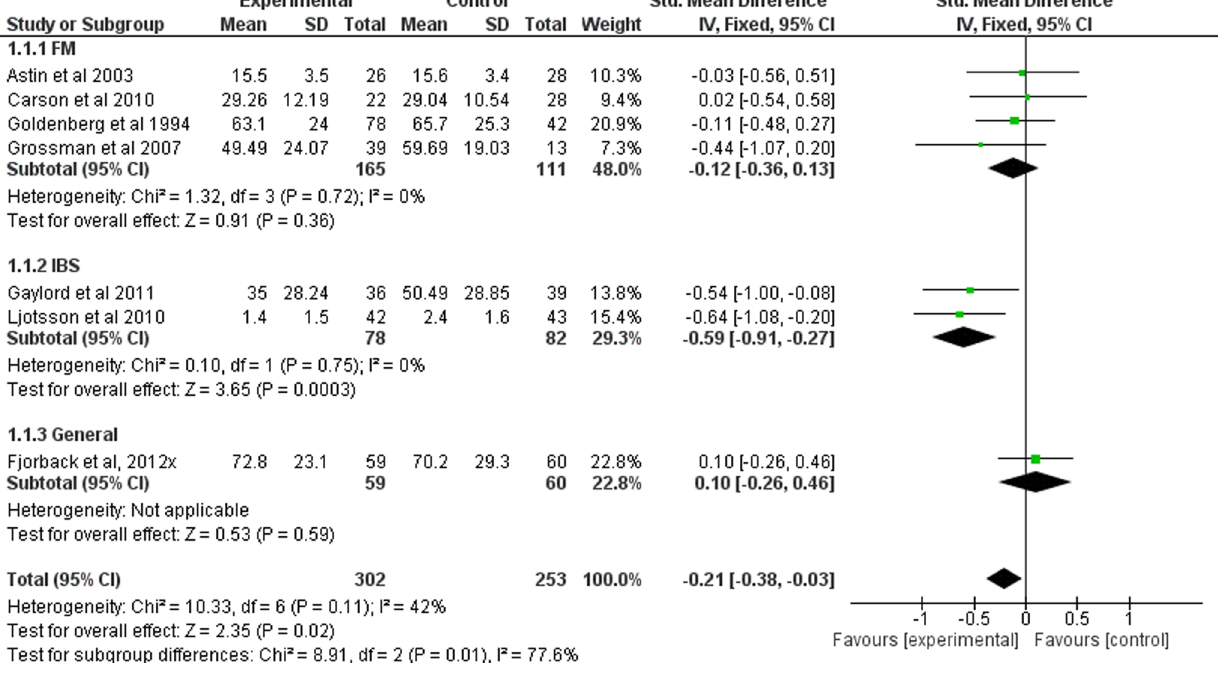
Figure 9. Forest plot showing the effect of mindfulness therapy on the pain outcome measure. Standardised mean difference between experimental and control group indicates that the mindfulness-based therapy group showed significantly more improvement than the control group, in only IBS.